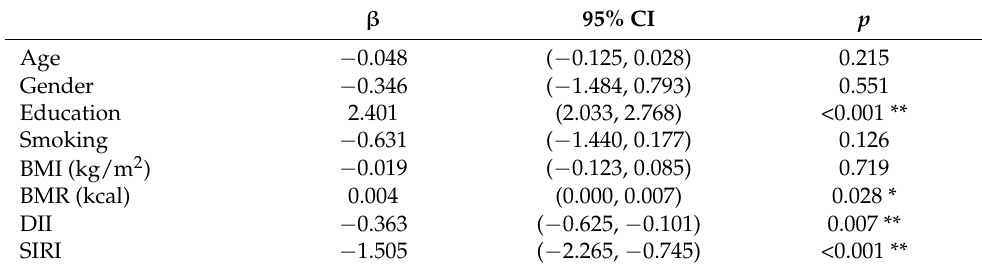
Table 3. Association between DII, SIRI and cognitive function.